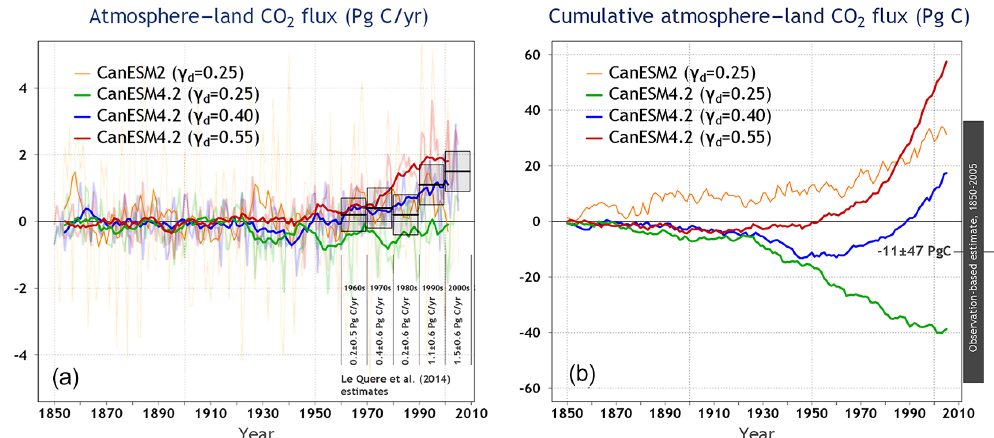
Figure 4. Atmosphere–land CO 2 flux ( F L ) (a) and its cumulative values e F L (b) from CanESM2 and the three CanESM4.2 historical 1850– 2005 simulations for different strengths of the terrestrial CO 2 fertilization effect. In (a) the observation-based estimates of F L and their uncertainty (shown via boxes) for the decades of 1960, 1970, 1980, 1990, and 2000 are reproduced from Le Quéré et al. (2015). The bold lines in (a) are the 10-year moving averages of the annual F L values, which are shown in light colours. The results from CanESM2 and CanESM4.2 are the average of the two ensemble